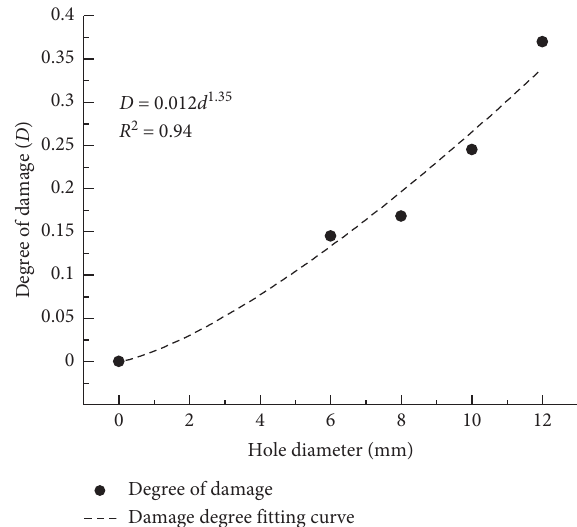
Figure 13: Yellow sandstone damage curve under the action of